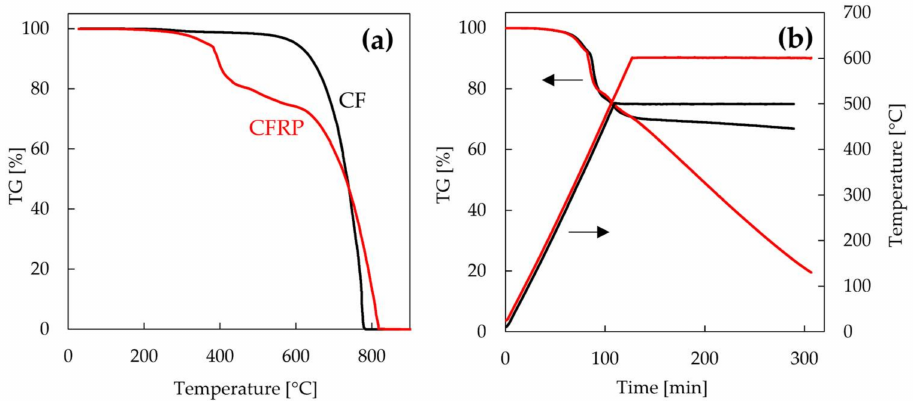
Figure 2. Thermogravimetric (TG) curves of carbon fiber (CF) and carbon fiber-reinforced plastic (CFRP) as a function of temperature ( a ) and CFRP as a function of time under isothermal conditions of 500 and 600 ◦ C ( b ).